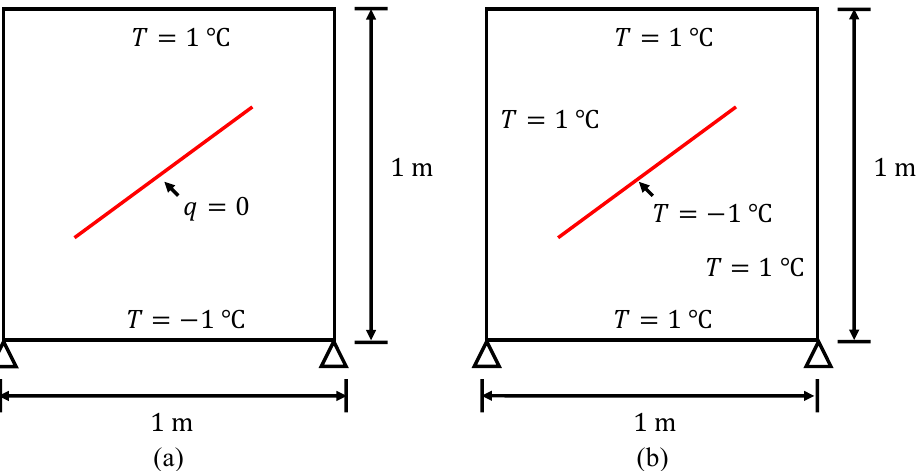
Figure 4. Geometry and boundary conditions of a square plate with a slant center crack: ( a ) adiabatic case; ( b ) isothermal case.